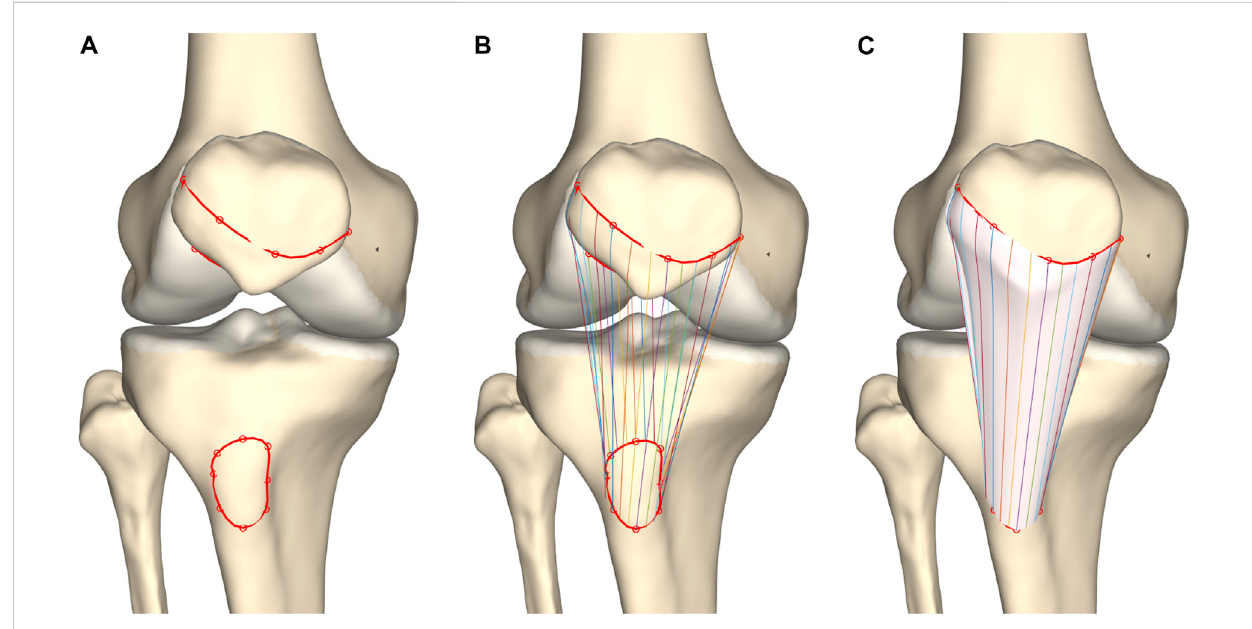
FIGURE 5 Frontal view of the knee joint. (A) Splines were formed interconnecting patellar origin and tibial insertion vertices. (B) Corresponding coordinates were connected. (C) Tendon modeling was based on a custom-made mesh wrapping